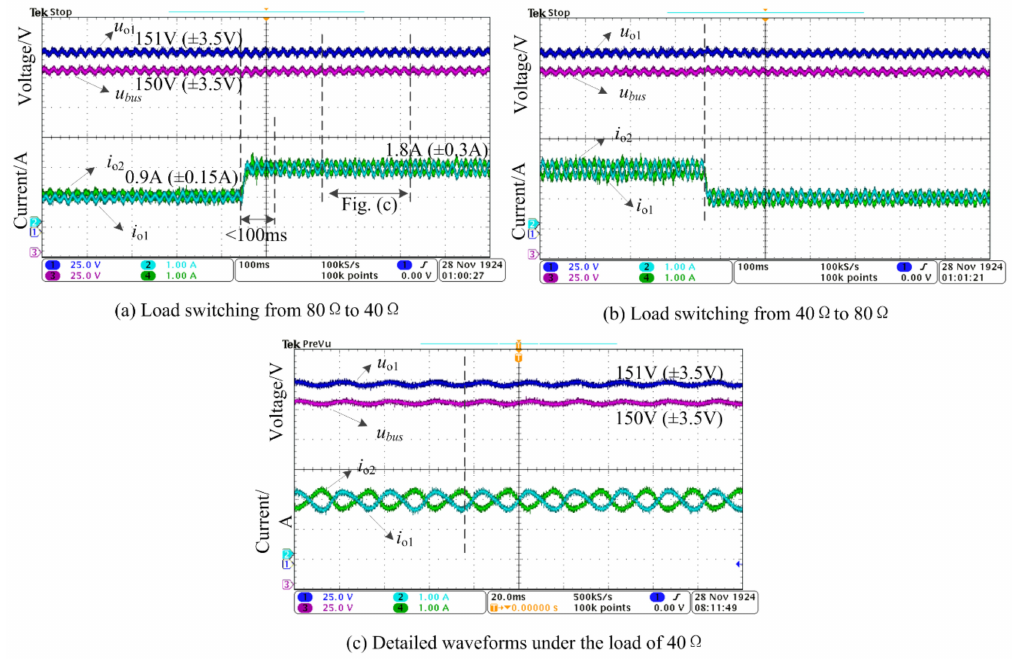
Figure 13. Experimental results of two parallel converters with equal rating.